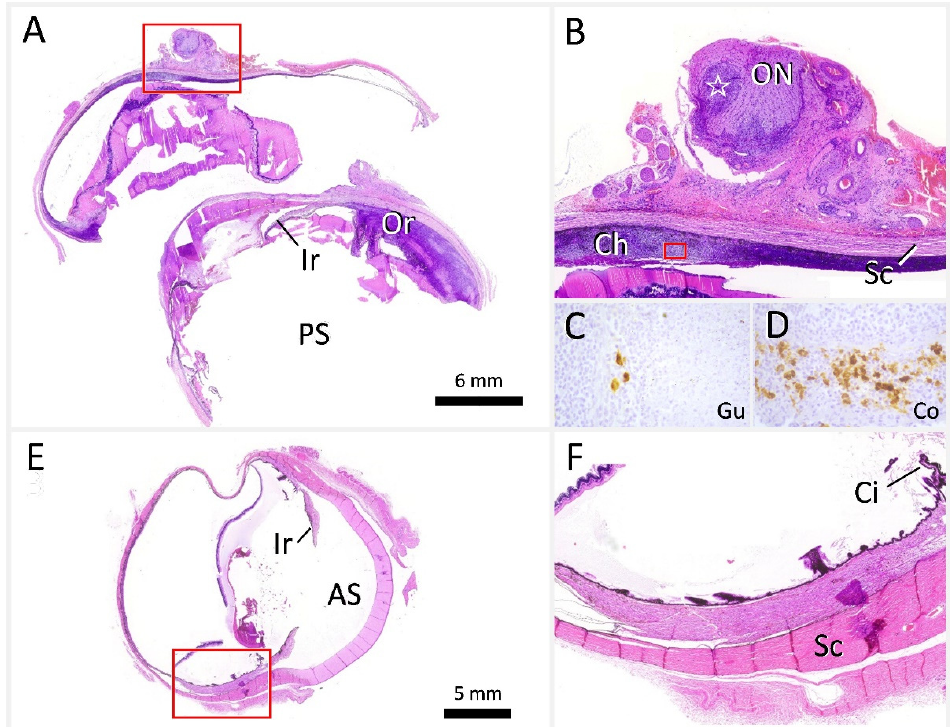
Figure 7. Comparison of the left eye ( A , B , C ), enucleated before antiviral treatment, and the right eye ( E , F ), harvested during necropsy. The feline infectious peritonitis (FIP)-affected left eye showed extensive pyogranulomatous and lymphocytic inflammation affecting mainly the optic nerve ( A ; B : ON, asterisk) and choroid ( A ; B : Ch), thereby extending from the posterior pole to the ora serrata ( A : Or). Fibrin precipitates, proteinaceous fluid, and free-floating cells were abundantly present in both anterior and posterior segments ( A : PS). On immunohistochemistry of Gusti´s left eye ( C : Gu), there were scattered brown macrophages immunopositive for feline coronavirus antiges. The signal was similar to that of polymerase chain reaction (PCR)-confirmed control tissue ( D : Co). No such changes were observed in the right eye ( E , F ) from necropsy. Markers: AS, anterior segment; Ch, choroid; Ci, ciliary body; Ir, iris; ON, optic nerve; Or, ora serrata; PS, posterior segment; Sc, sclera. Stain ( A , B , E , F ): hematoxylin–eosin. Stain ( C , D ): diaminobenzidine tetrahydrochloride (brown), hematoxylin counterstain. Red frames: localisers of higher magnification pictures: ( A , B ; B , C ; E , F